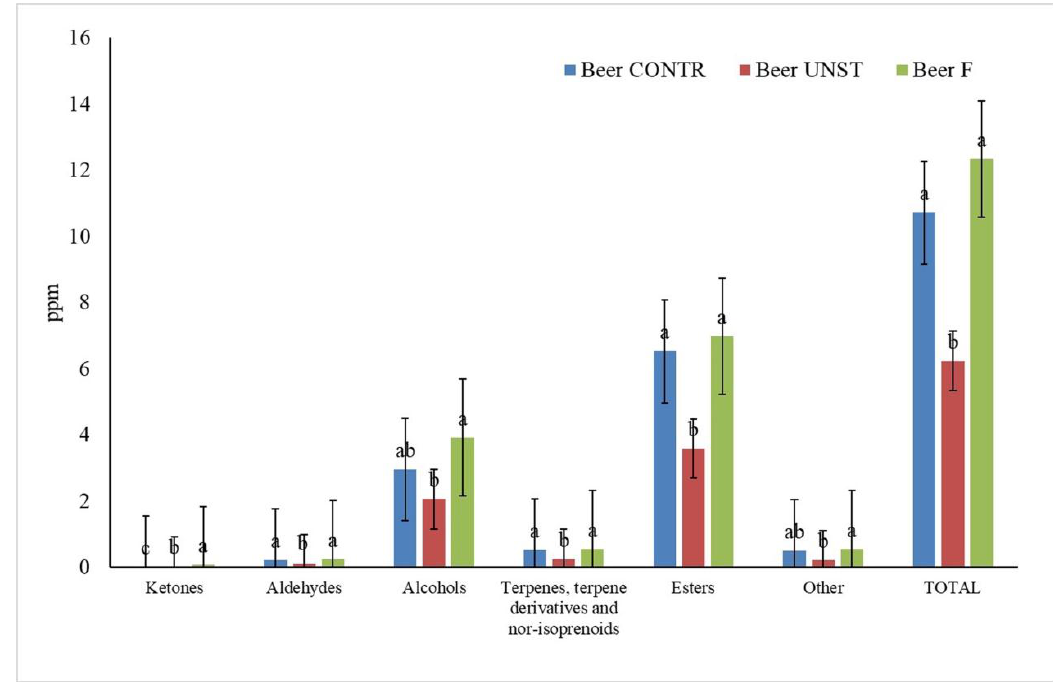
Figure 3. Effect of unstarted and fermented apple pomace addition on volatile composition of beer after 30 days of maturation. One-way ANOVA, Tukey’s test ( p ≤ 0.05). letters a–c: mark significant di ff erences / analogies among the samples. Beer CONTR: Beer with no added apple pomace ( ); Beer UNST: beer with added unstarted apple pomace ( ); Beer F: beer with added Lactobacillus rhamnosus 1473 fermented heated apple pomace ( ).